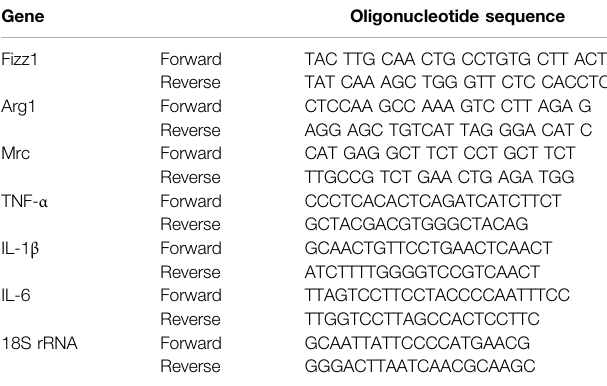
TABLE 2 | | List of primers for quantitative Real-Time